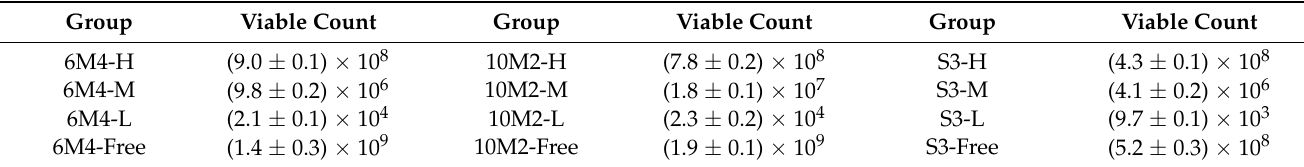
Table 1. Viable number of B. longum in different groups.